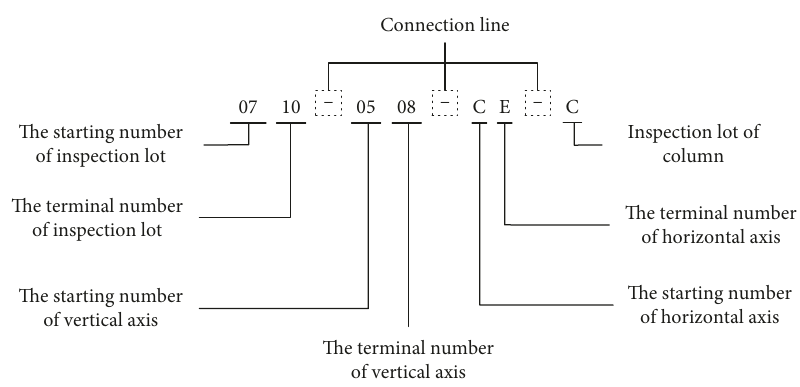
Figure 8: Example encoding of inspection lot of Column. Table 10: Encoding of valuation indicator.